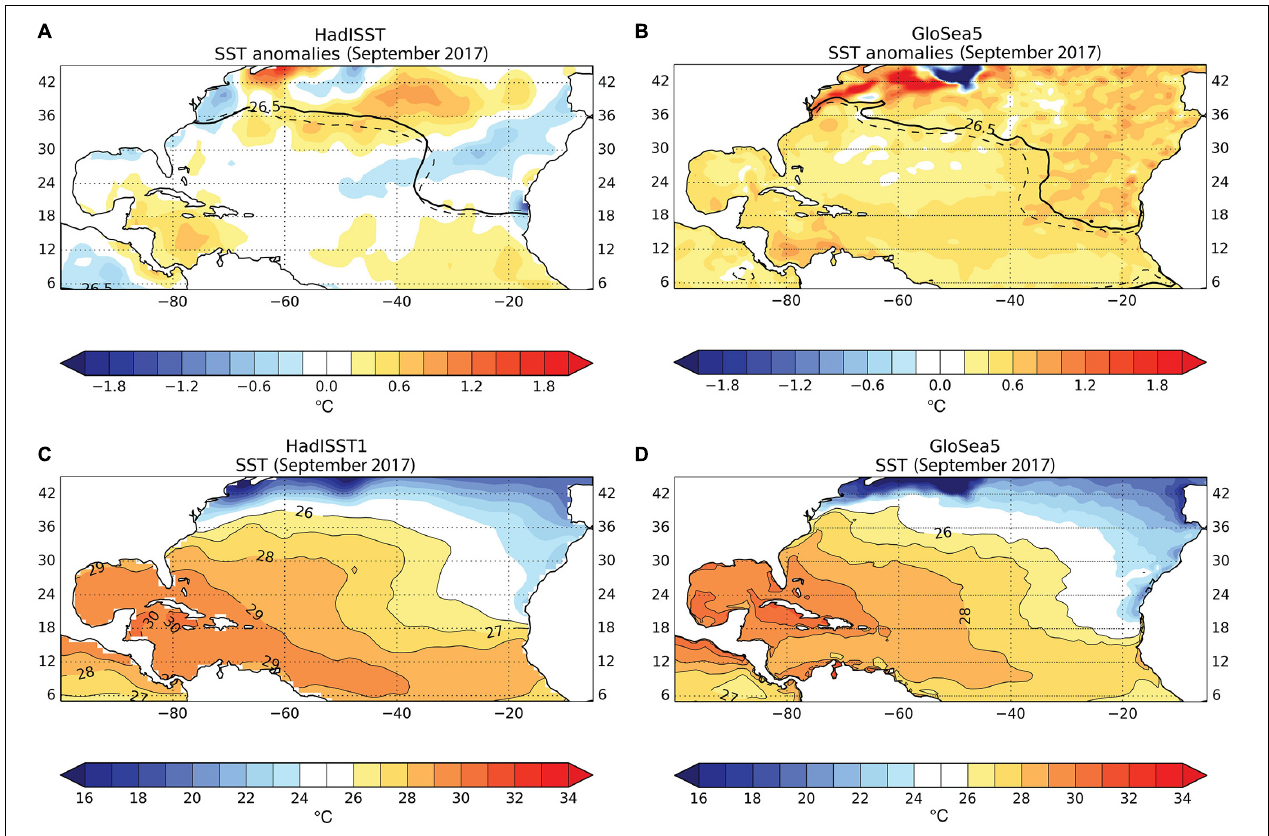
FIGURE 7 | North Atlantic sea surface temperature forecasts: (A) observed and (B) forecast mean Atlantic SST anomalies during September 2017. The location of the 26.5 ◦ C isotherm during September 2017 (solid black line) relative to average September conditions during 1993–2015 (dashed line) are also shown. (C) Observed and (D) forecast mean Atlantic SSTs during September 2017. Anomalies relative to September 1993–2015. Adapted from Camp et al.